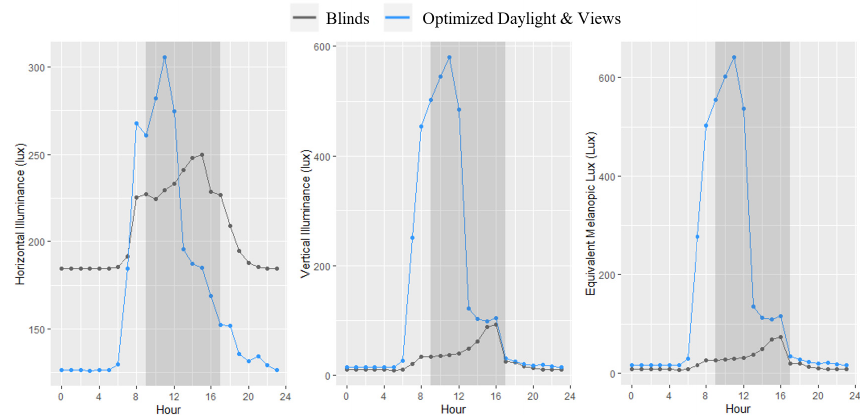
Figure 2. Daily variation in horizontal illuminance, west-facing vertical illuminance, and west-facing vertical equivalent melanopic lux in the two office environments.